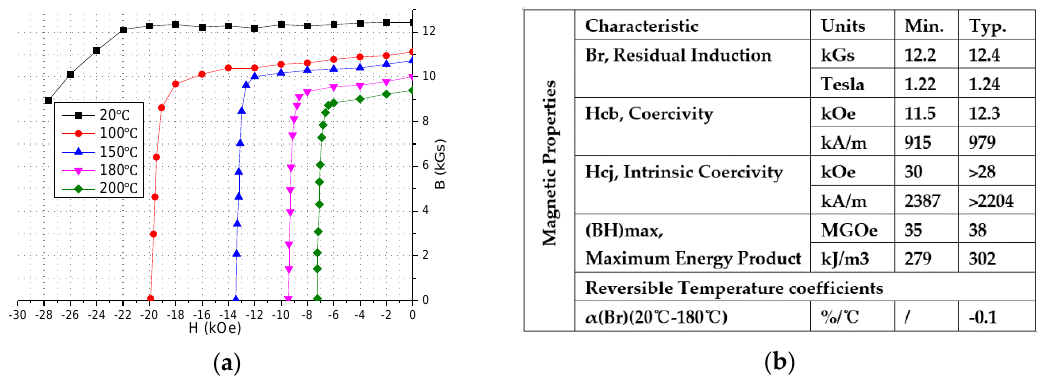
Figure 9. The magnetic properties and demagnetization curves: ( a ) Demagnetization curves; ( b ) Magnetic properties.